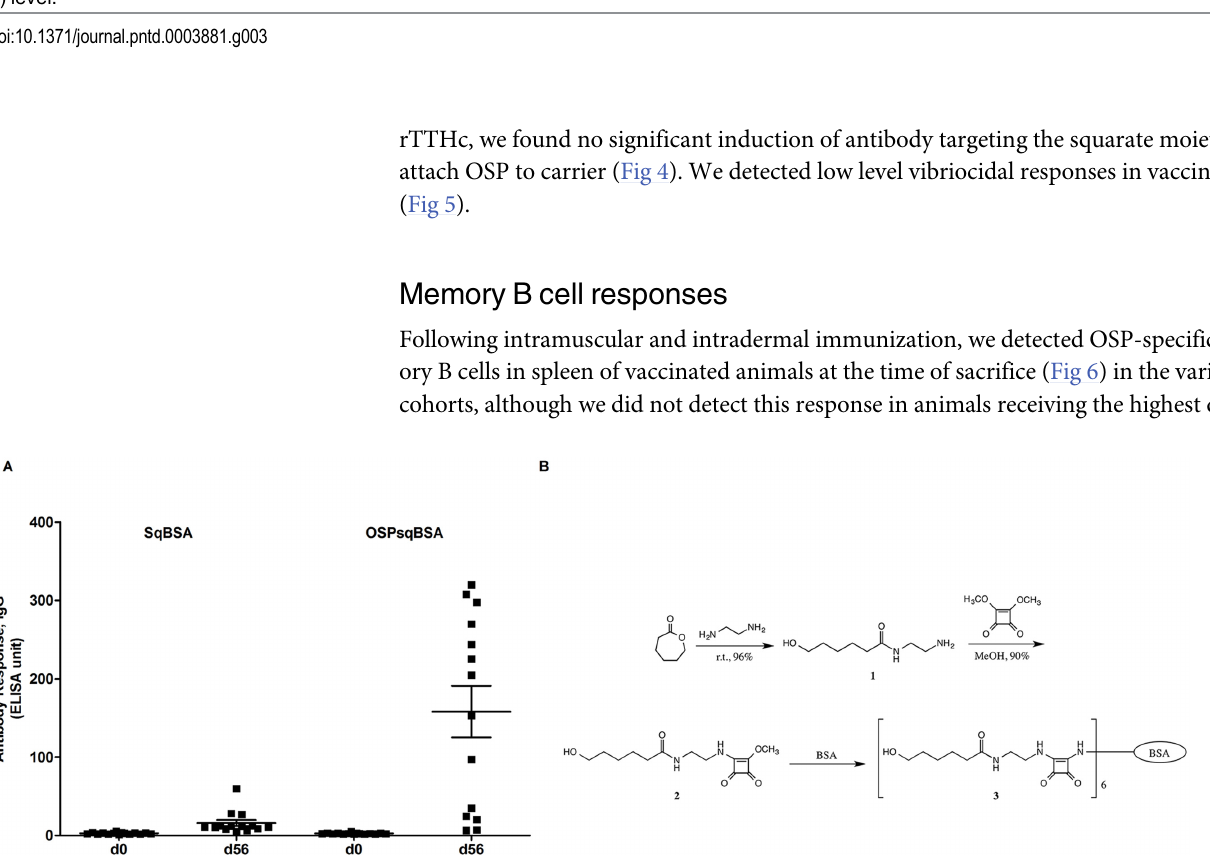
Fig 3. Serum IgG responses at different time points against (A) O-specific polysaccharide (OSP) and (B) tetanus toxoid (TT) in various vaccine cohorts following intramuscular (IM) or intradermal (ID) immunization with various doses (based on OSP component) and/or loading ratios of OSP to TTHc, with or without adjuvant alum. Mice were immunized on days 0, 21, and 42. Responder frequency reflects a 15-fold increase over baseline for anti-OSP IgG, and 30-fold increase for anti-TT IgG. An asterisk denotes a statistically significant difference ( P < 0.05) in the mean response from baseline (day 0) level.